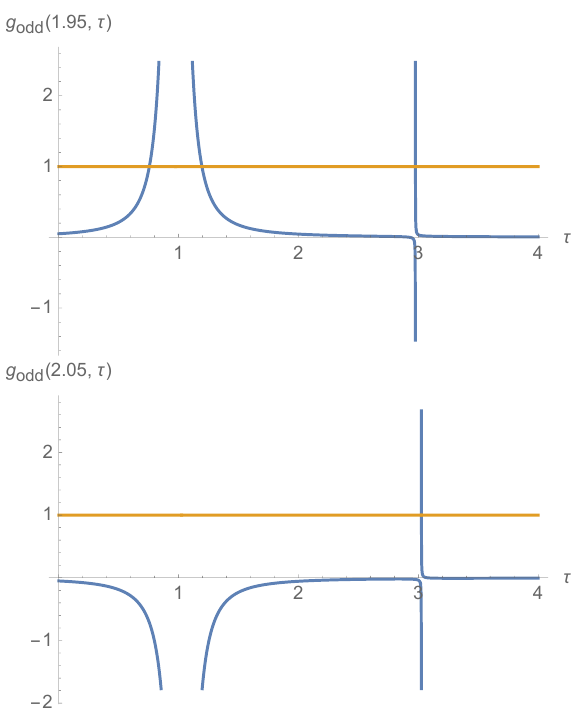
Figure 6. A plot g odd ( (cid:28) ) and 1 for d = 1 : 95 (top) and d = 2 : 05 (below).